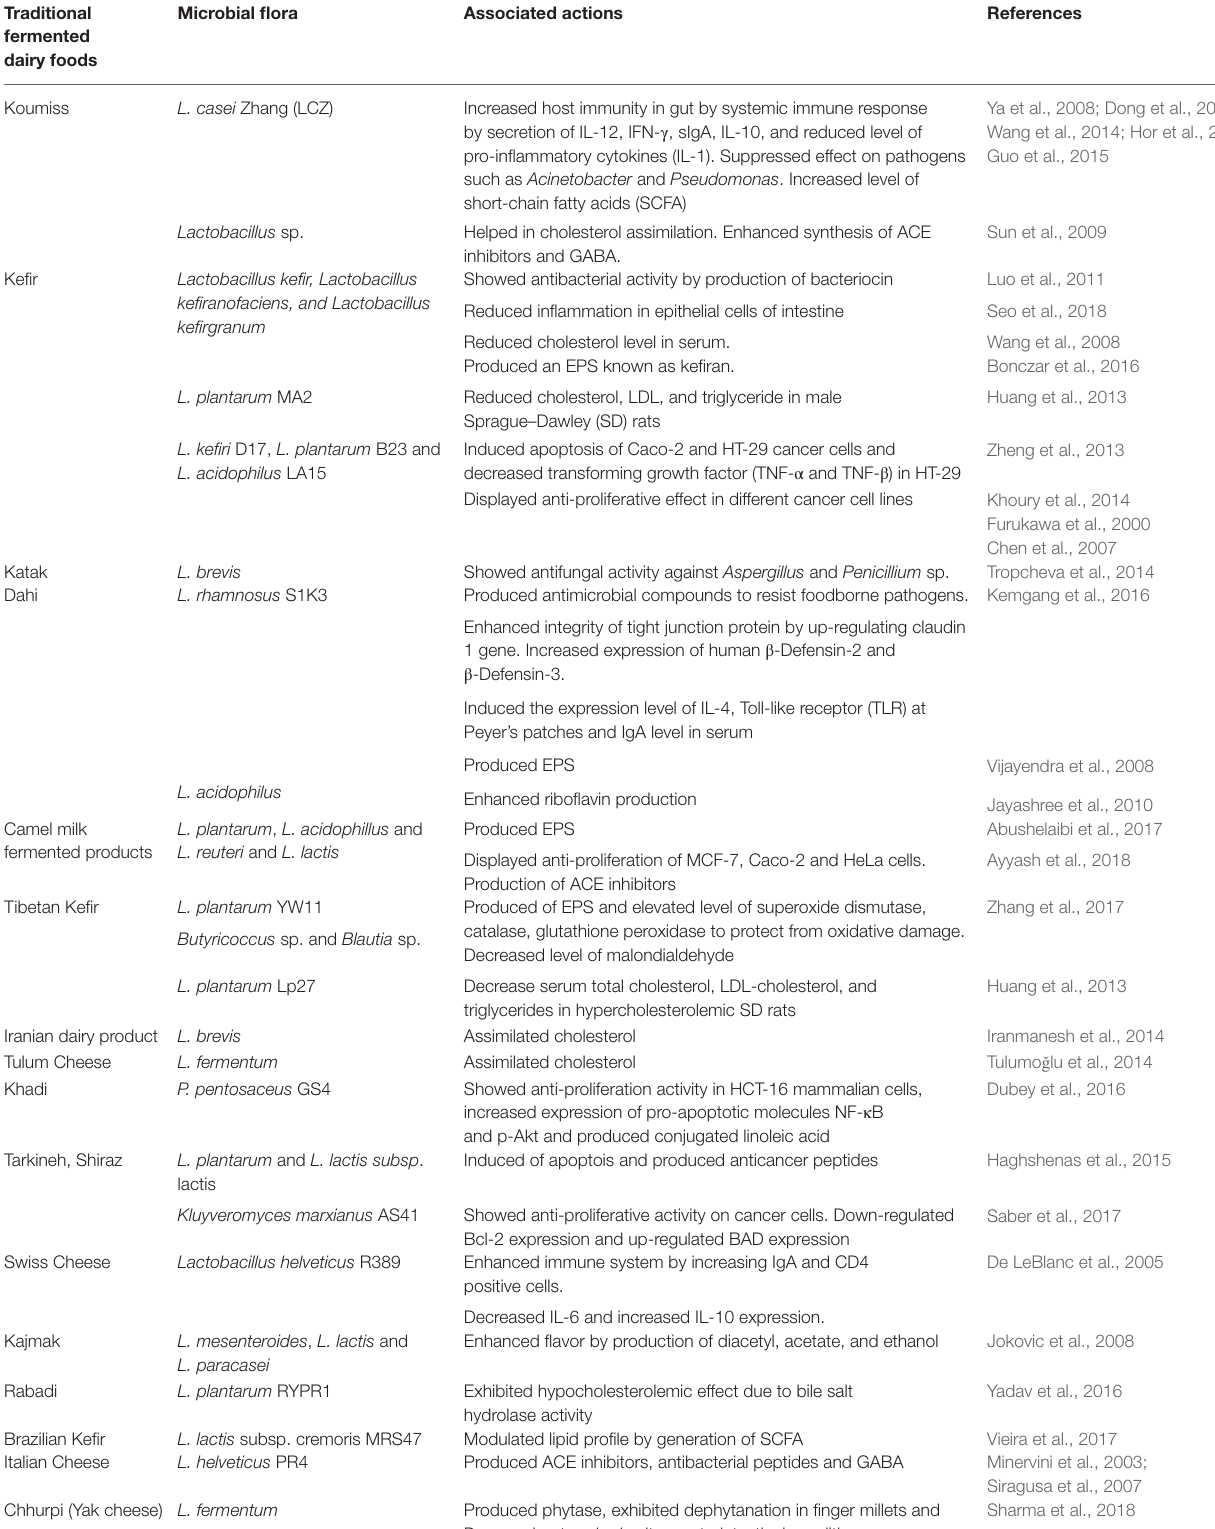
TABLE 1 | Therapeutic and beneficial properties of ethnically fermented dairy products and associated